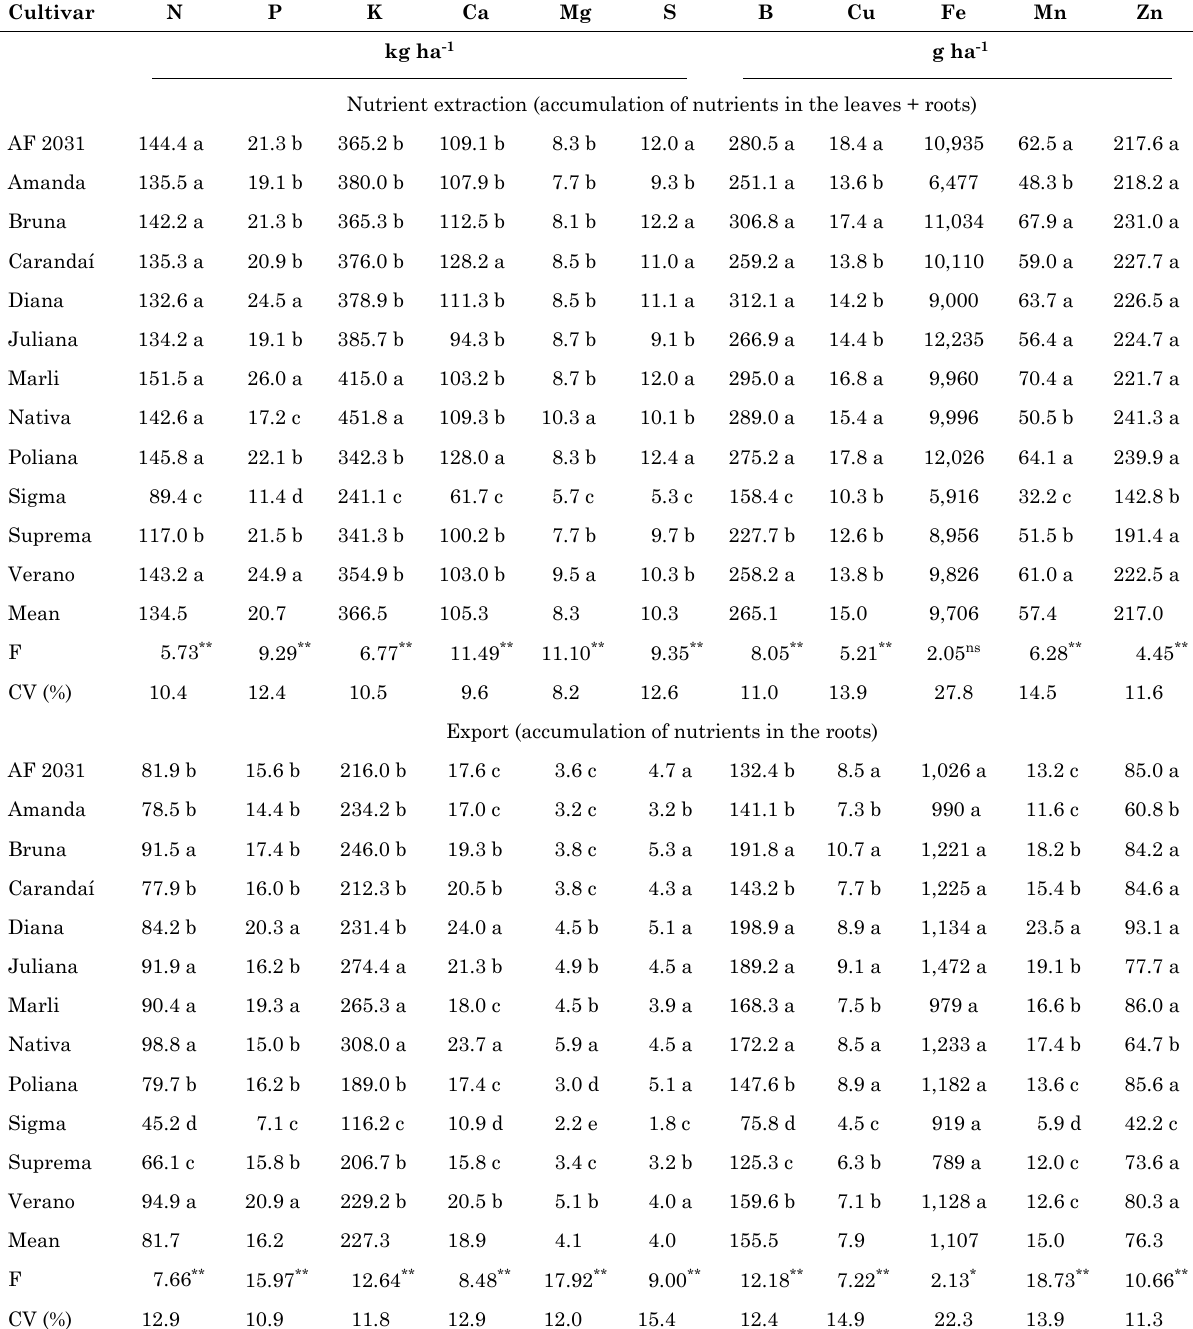
Table 6. Nutrient extraction and export by summer carrot cultivars sown in the summer-winter transition crop season (Experiment 2)